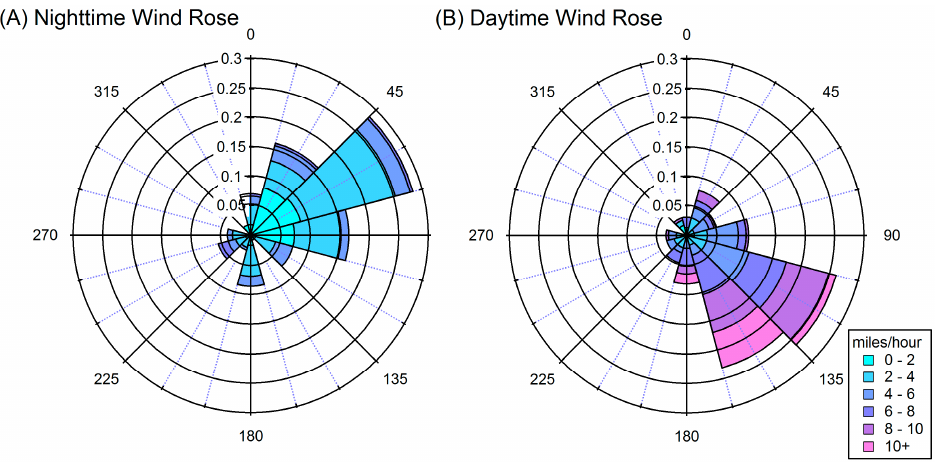
Figure 6. Wind rose plots for ( A ) night (0:00–6:00) and ( B ) day (12:00–18:00) averaged over the course of the campaign.